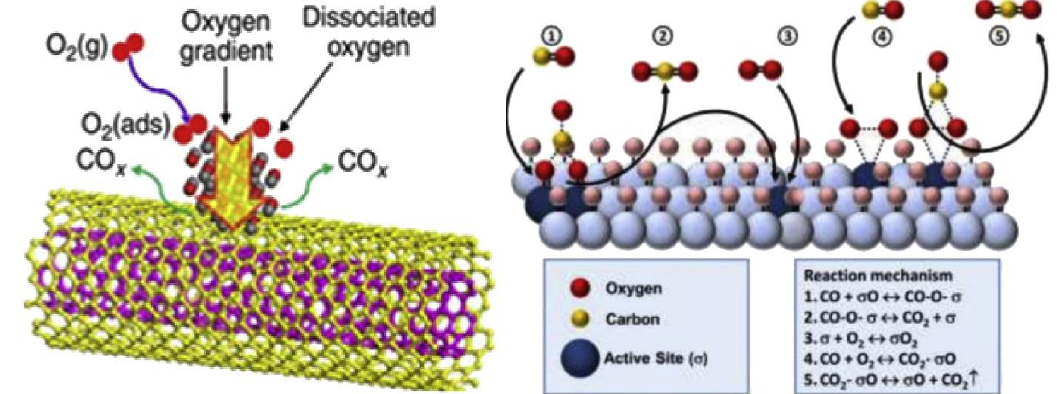
Figure 6. Mechanism of CO oxidation over a CuMnOx catalyst. Reproduced with permission from Dey and Dhal [97]. Copyright 2019 Elsevier Ltd.